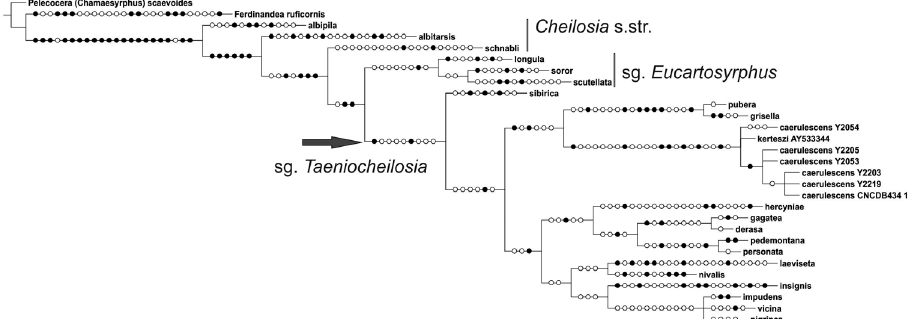
Figure 13. Parsimony analysis based on mtDNA COI barcodes. Strict consensus tree of two equally parsimonious trees. Nucleotide changes indicated, filled circles denote unique changes to this dataset, open circles non-unique.